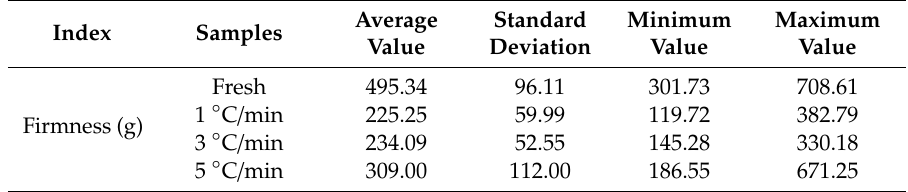
Figure 7. Prediction results of the firmness of the pears using the PLS method with different numbers of cycles: ( a ) the MSC calibration set; ( b ) the MSC validation set; ( c ) the S-G-MSC calibration set; ( d ) the S-G-MSC validation set; ( e ) the S-G-SNV calibration set; ( f ) the S-G-SNV validation set; ( g ) the SNV calibration set; and ( h ) the SNV validation set. Table 8. Firmness values of the Nanguo pears.